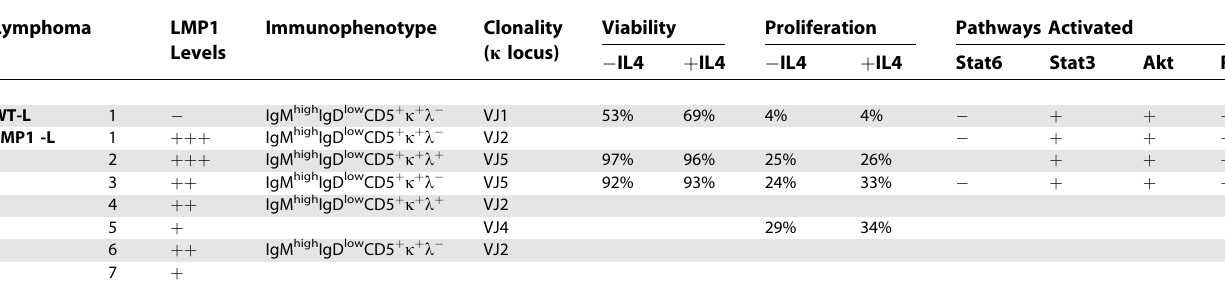
Table 1. Summary of Analysis Performed on Wild-Type and LMP1 Transgenic Lymphomas